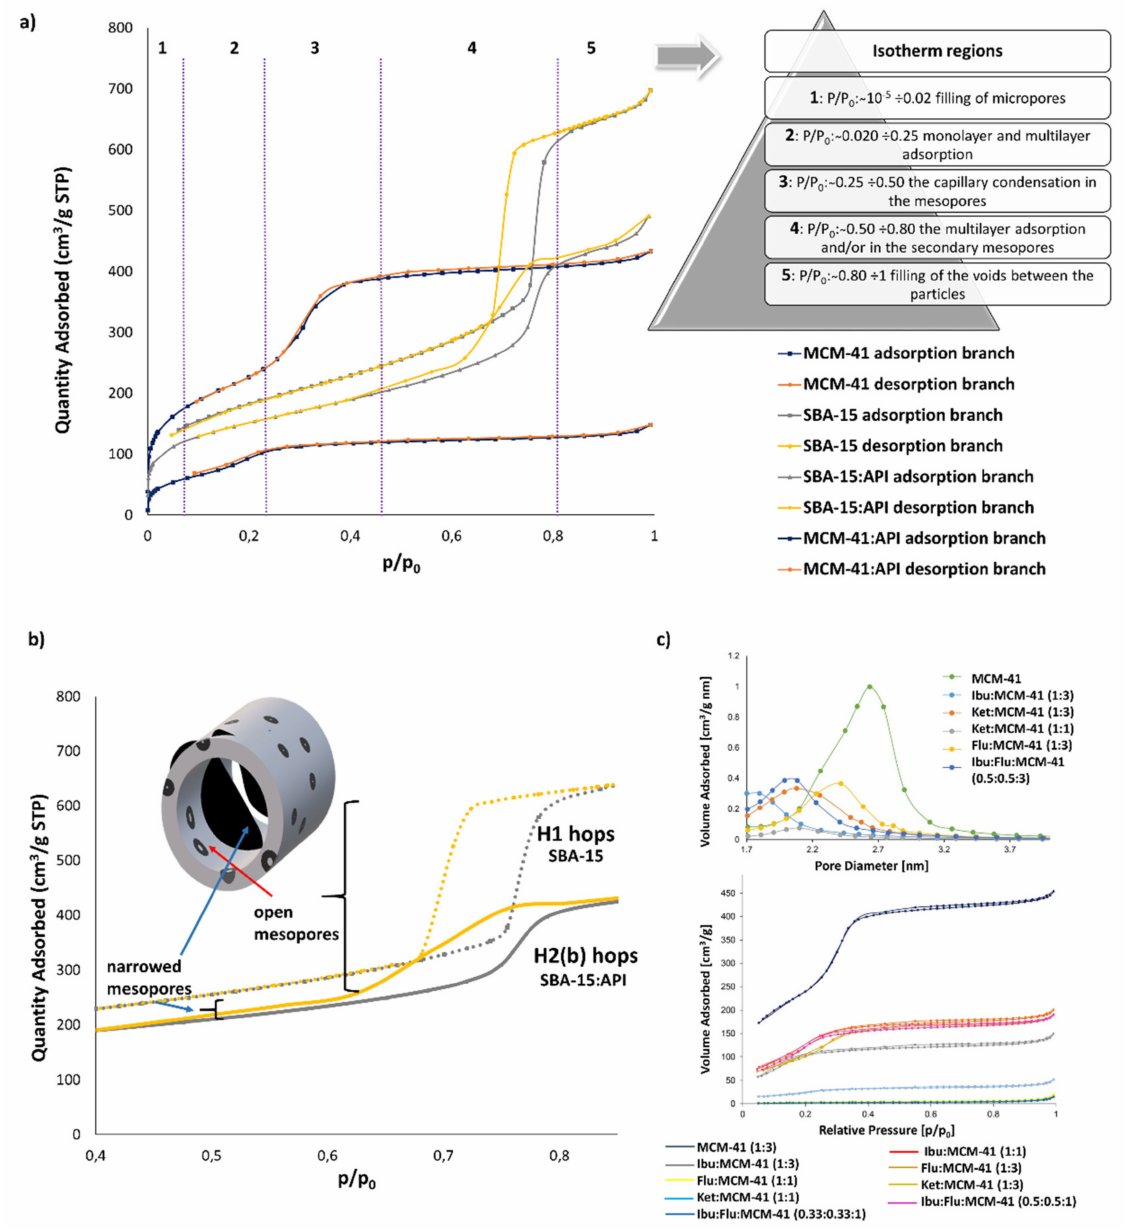
Figure 8. ( a ) The illustration of nitrogen adsorption/desorption isotherms, and ( b ) hysteresis loop results of SBA-15 and samples of SBA-15 with API. Data provided courtesy of Katarzyna Trzeciak. ( c ) Pore diameter distributions of MCM-41 and drug-loaded samples (up pictures) and nitrogen adsorption-desorption isotherms MSM-41 and drug-loaded samples (down pictures) in various weight ratios prepared by DiSupLo method. Adapted with permission from [47], Copyright 2020